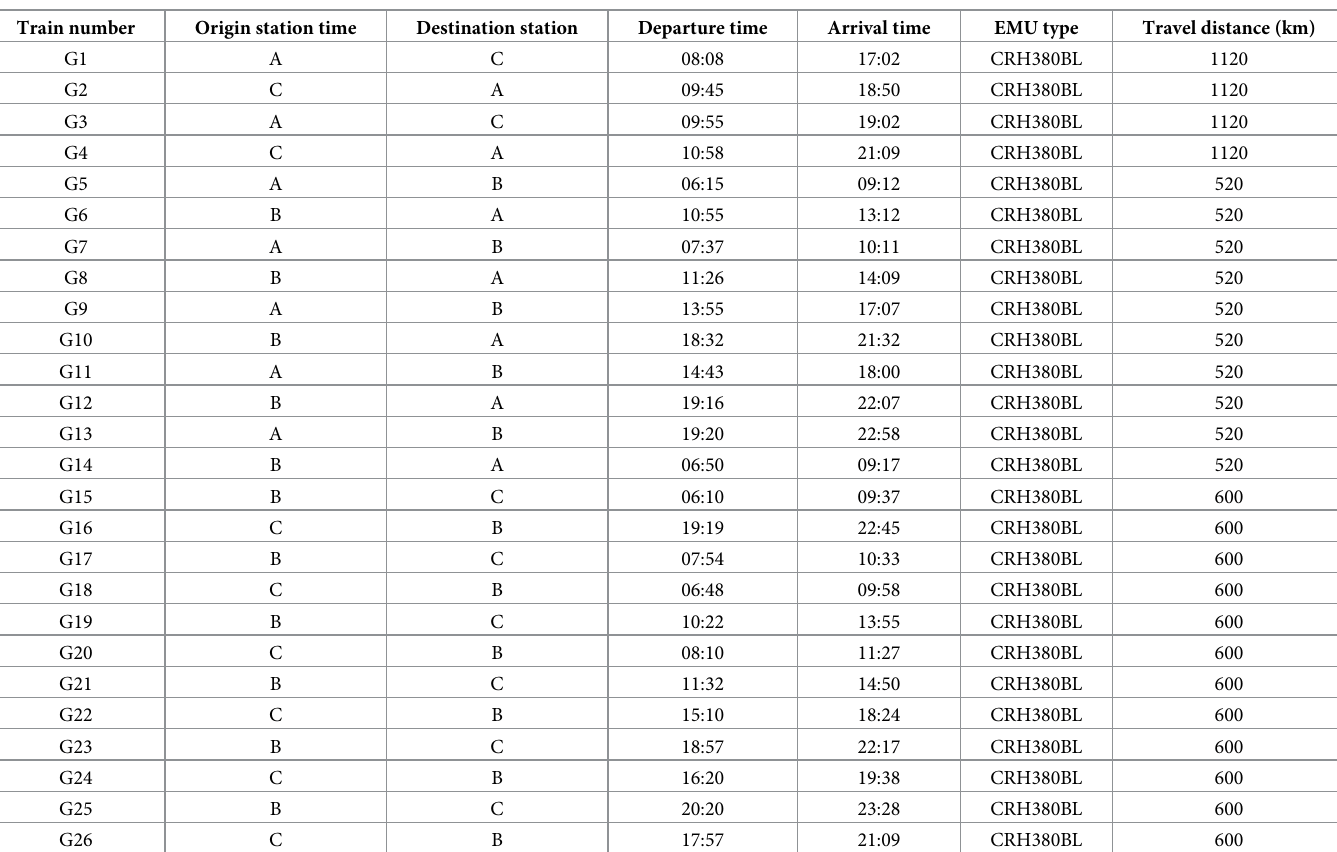
Table 8. Train information for the case.